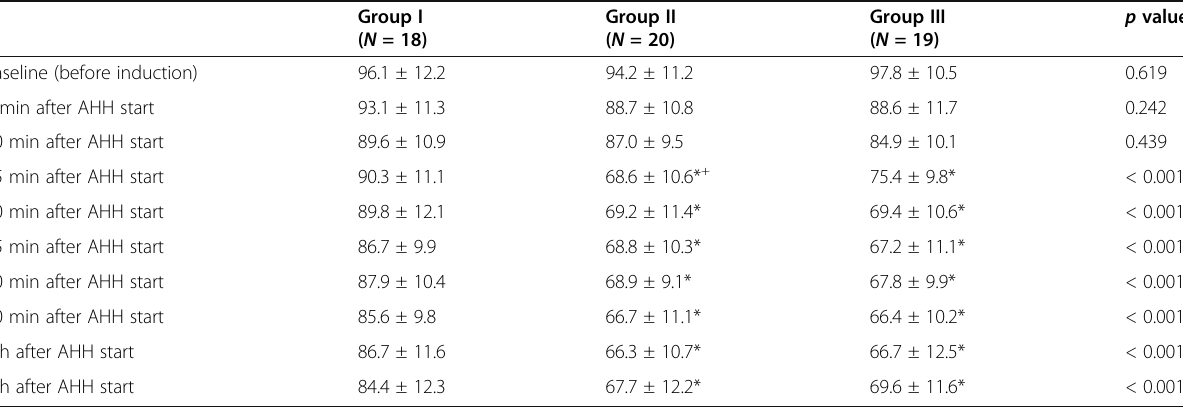
Table 5 Mean arterial blood pressure expressed in mmHg in the three study